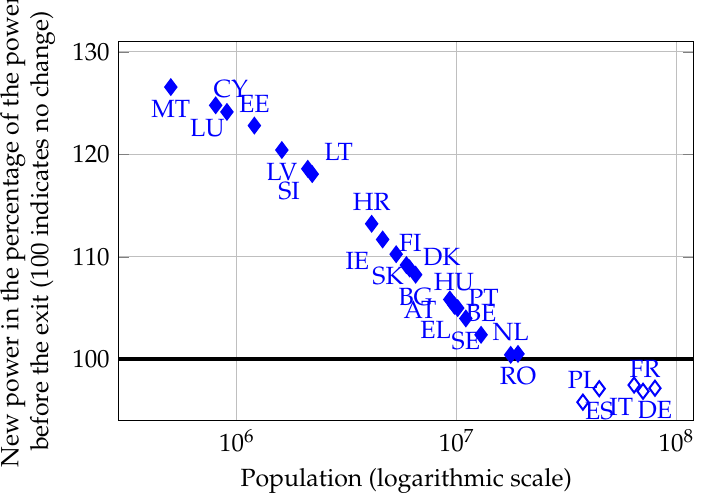
Figure 2. Effect of Czexit with population projections for 2030, adjusted Shapley–Shubik